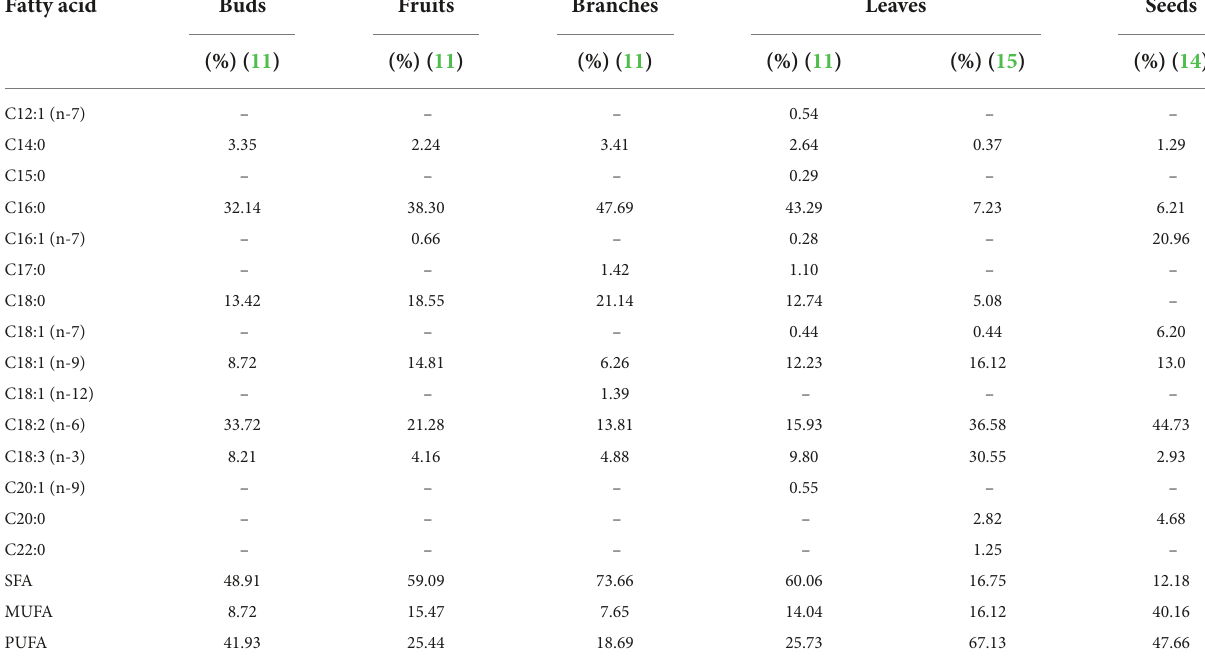
TABLE 2 Fatty acid composition in various parts of S. aromaticum